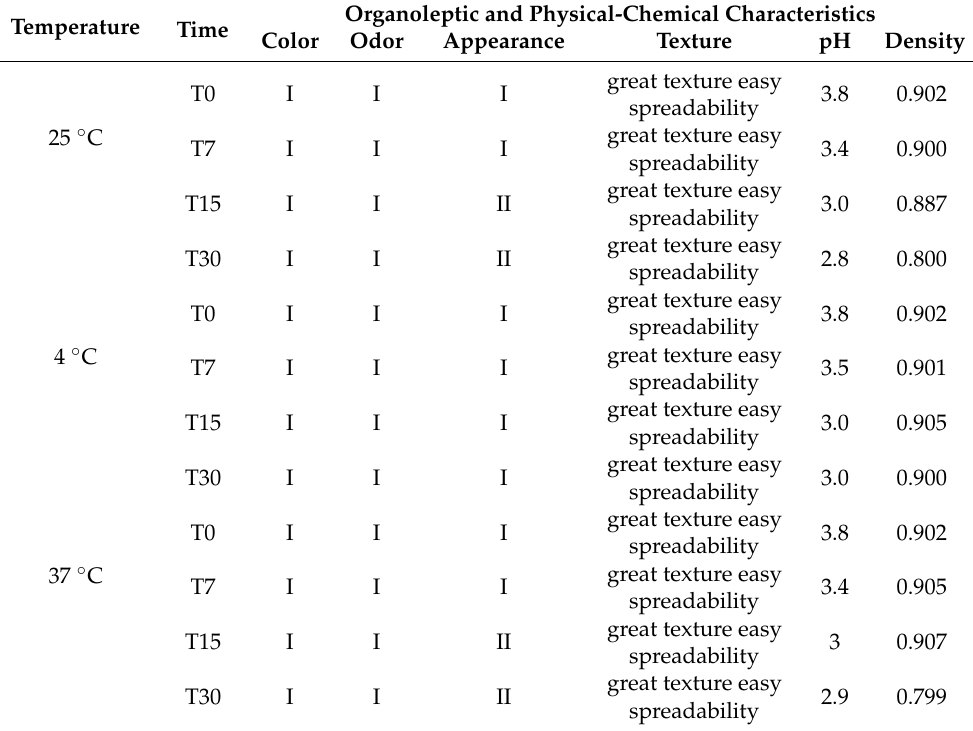
Table 4. Evaluation of the organoleptic characteristics of gel containing L. plantarum LP-G18-A11 in accelerated stability